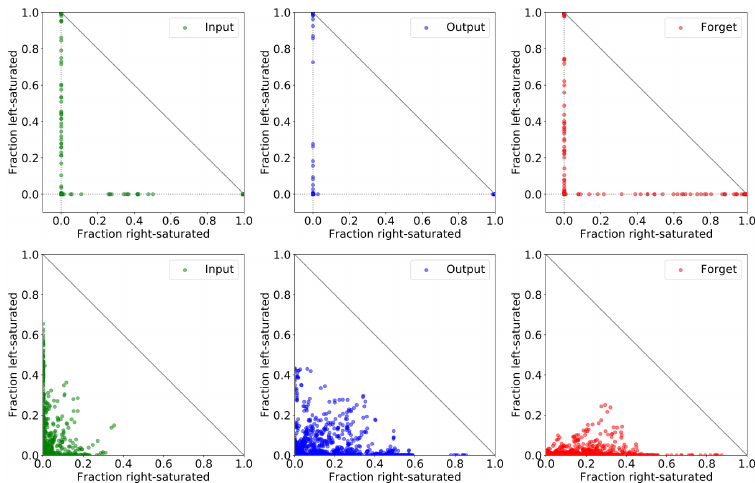
Figure 21: Fractions of saturation for units. The first row shows the units from an unconverged network. All the units are on the axes. The second row shows the units from a converged network. The units perform more differently among time steps. Each subfigure contains 1280